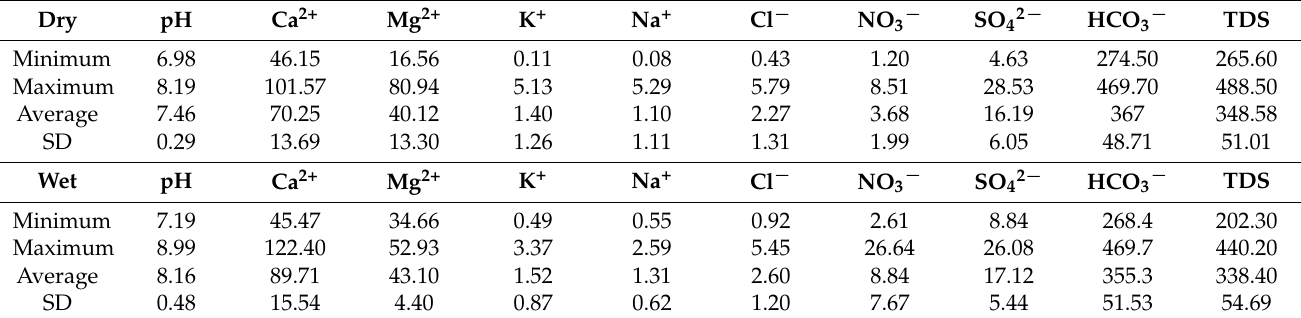
Table 1. Statistics of the hydrochemical parameters of the Huangzhouhe River Basin (mg · L − 1